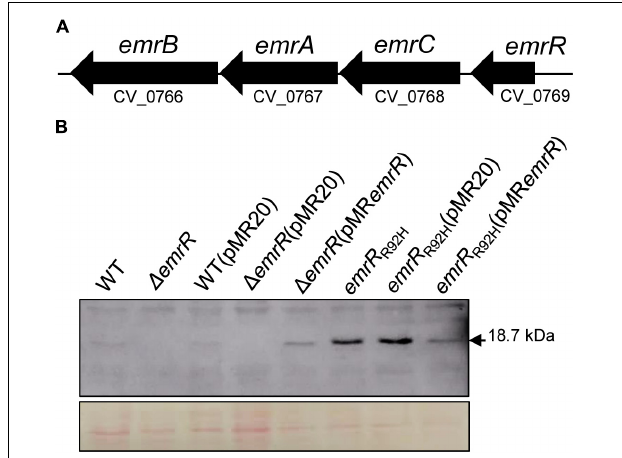
FIGURE 1 | Genomic analysis of the emrR / emrCAB cluster and molecular characterization of emrR mutant strains. (A) Scheme showing that the gene emrR is located near to the operon emrCAB on the chromosome of C. violaceum . (B) Western blot confirmed that deletion of the emrR gene abolished production of the EmrR protein, while point mutation in emrR resulted in an EmrR variant unable to autorepress its own production. Levels of EmrR in the indicated C. violaceum strains detected with anti-EmrR antiserum. Equal protein loading determined by membrane staining with Ponceau S (bottom